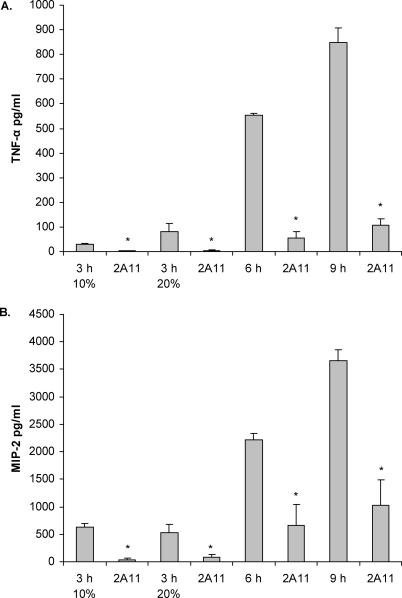
Cytokine and Chemokine Induction in Response to Different Heat-Killed Morphologies of A. fumigatus

A. fumigatus was grown for 3 h (in 10% or 20% serum), 6 h, or 9 h and thereafter subjected to heat-killing. Alveolar macrophages were added and incubated in the presence or absence of isotype or 2A11 for 6 h. Thereafter, cytokine and chemokine levels were determined in supernatants by Bio-Plex or ELISA. Asterisks represent significant differences between isotype (rat IgG) and 2A11 (p < 0.05). Figure 3 shows cumulative results from three experiments. Data are expressed as mean pg/ml + SEM.